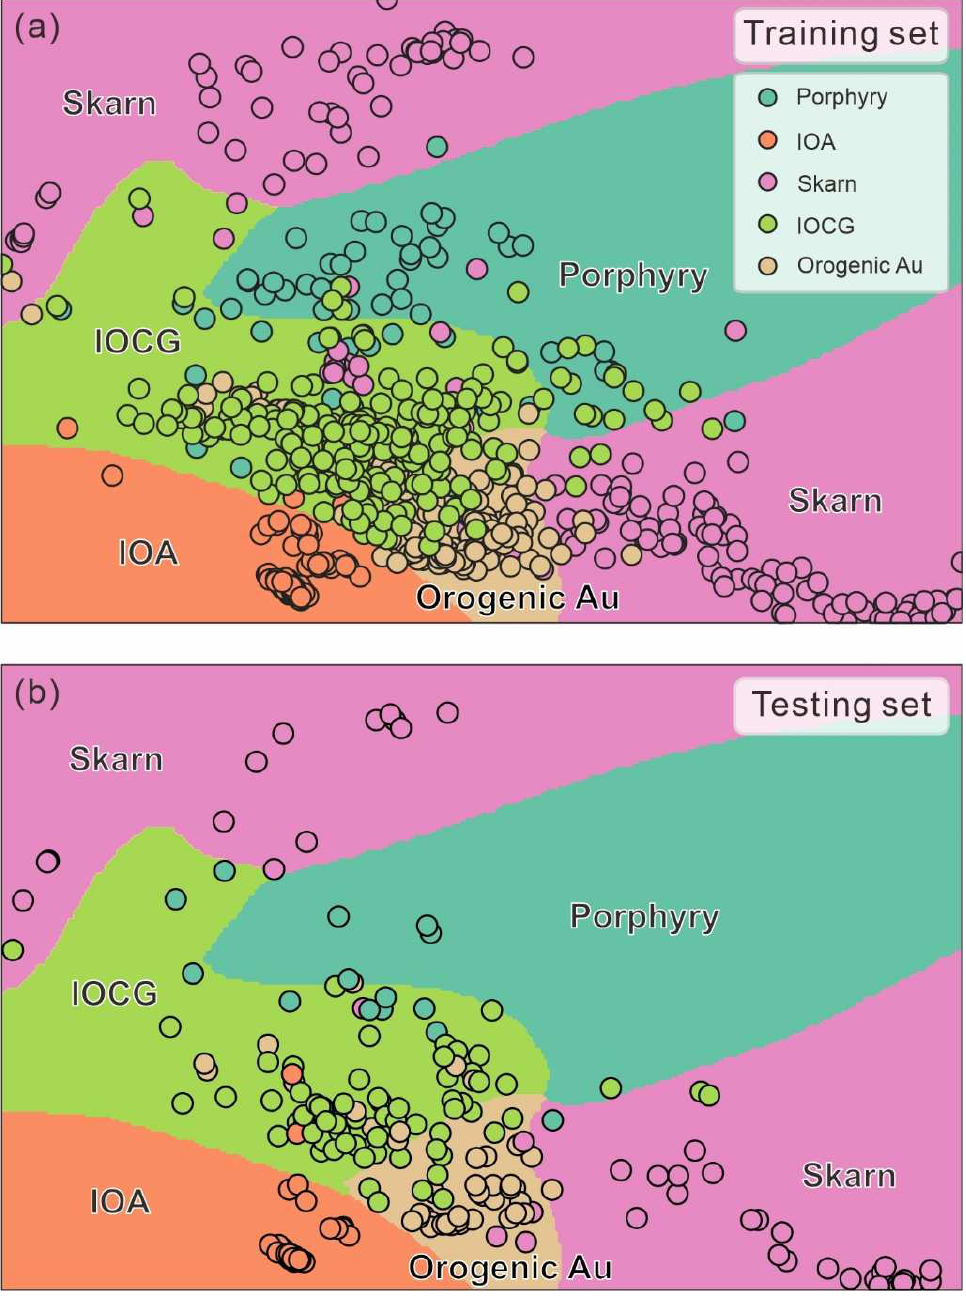
Figure 2. Supervised decision boundary map generated by the training set and the trained